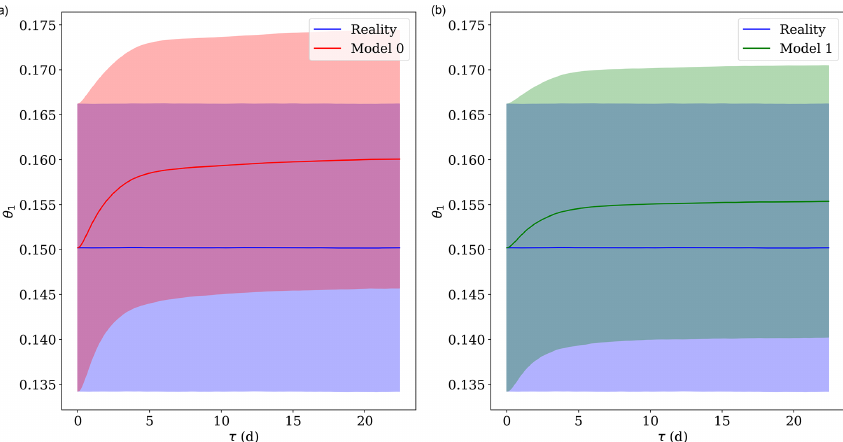
Figure 3. Behaviour of the averages as a function of the lead time τ in reality and the forecast models before (a) and after (b) the model change, for the experiment with a modification of the friction coefficient (see Table 1). The variable considered is the temperature meridional gradient θ 1 . The solid lines denote the mean, while the shaded areas denote the interval of 1 standard deviation.